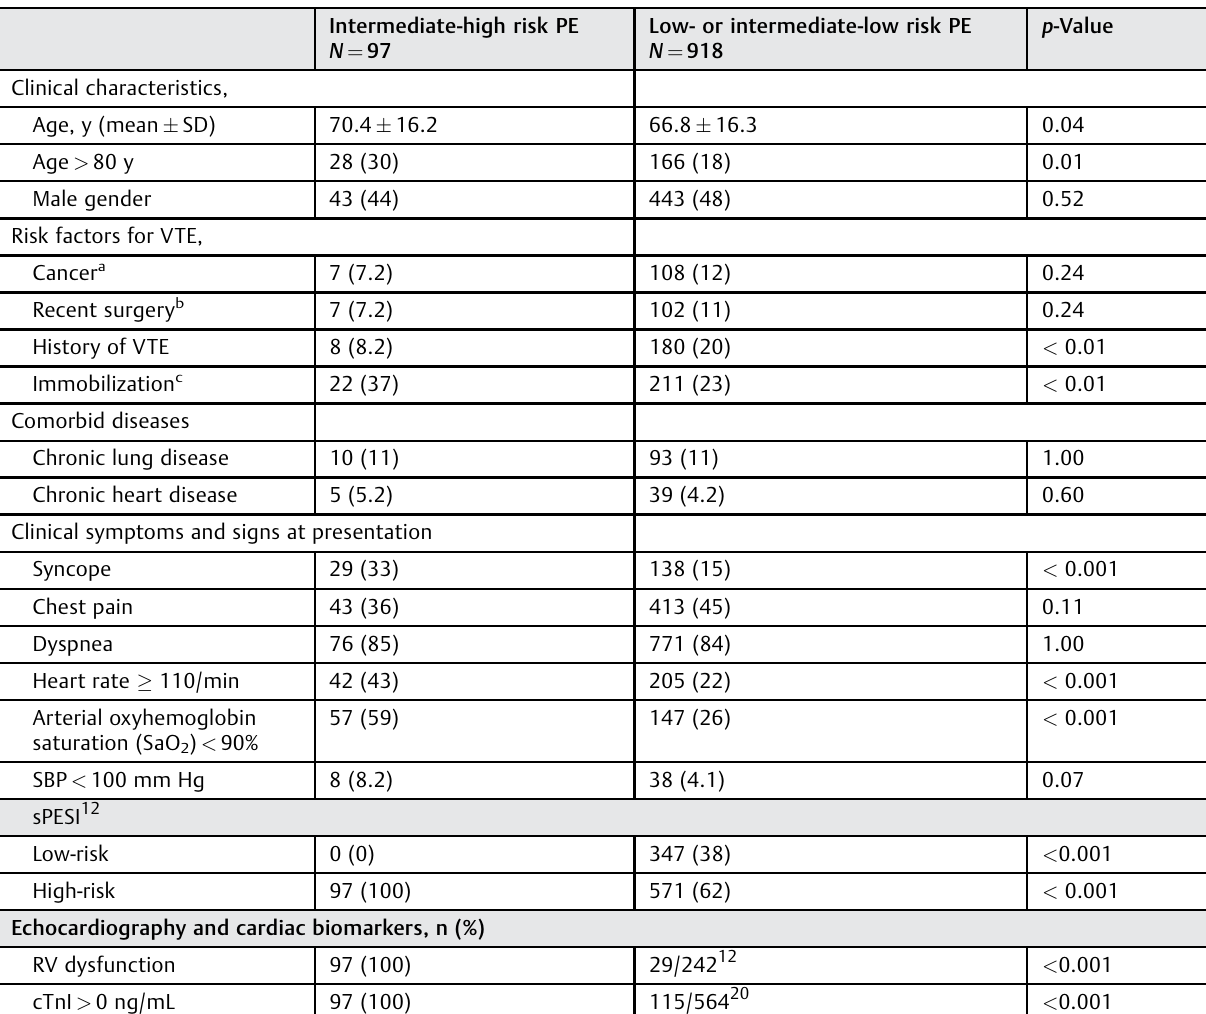
Table 1 Patient characteristics ( n ¼ 1,015)